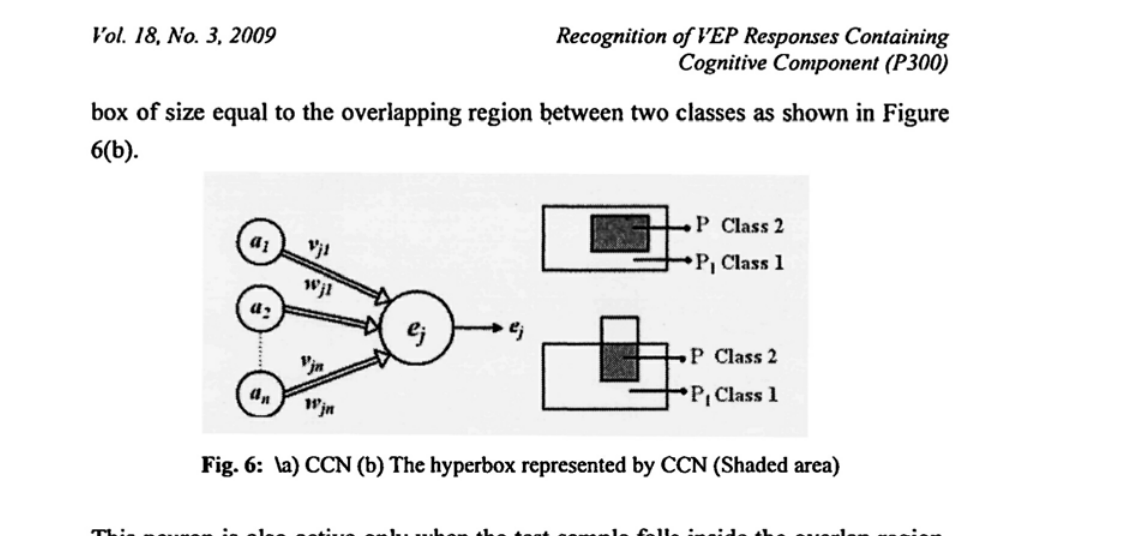
Fig. 6: \a) CCN (b) The hyperbox represented by CCN (Shaded area) This neuron is also active only when the test sample falls inside the overlap